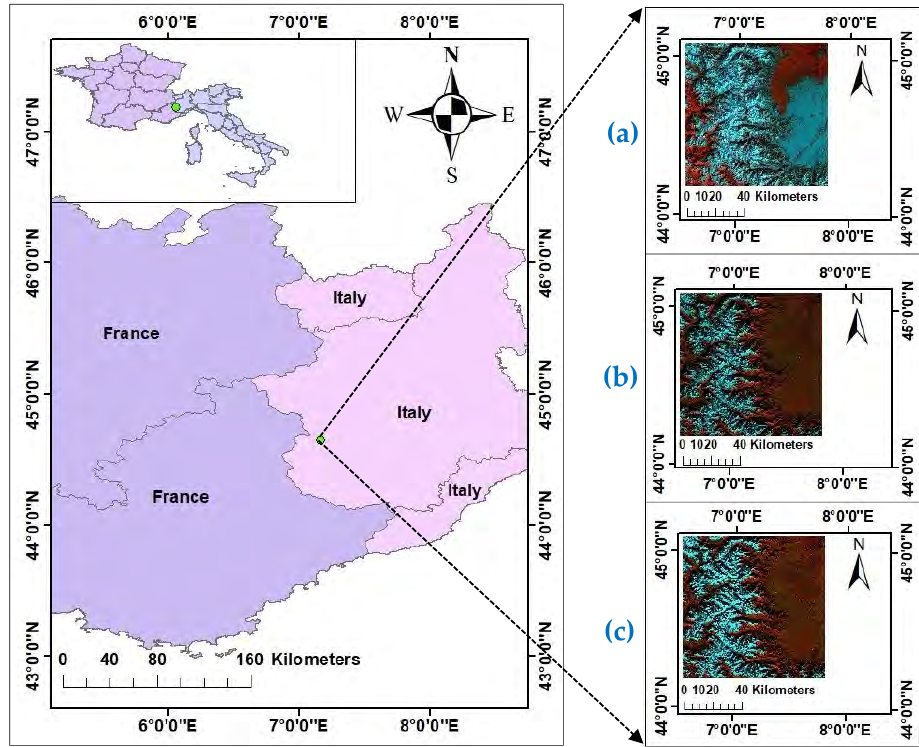
Figure 3. Location of the France–Italy region under study and false-color composite images of the region. Left panel represents the precise location of the study region between Italy and France. Right panels show the composite images using the green, NIR, and SWIR-2 bands for ( a ) Landsat 5 TM, ( b ) Landsat 8 OLI, and ( c ) Sentinel-2A